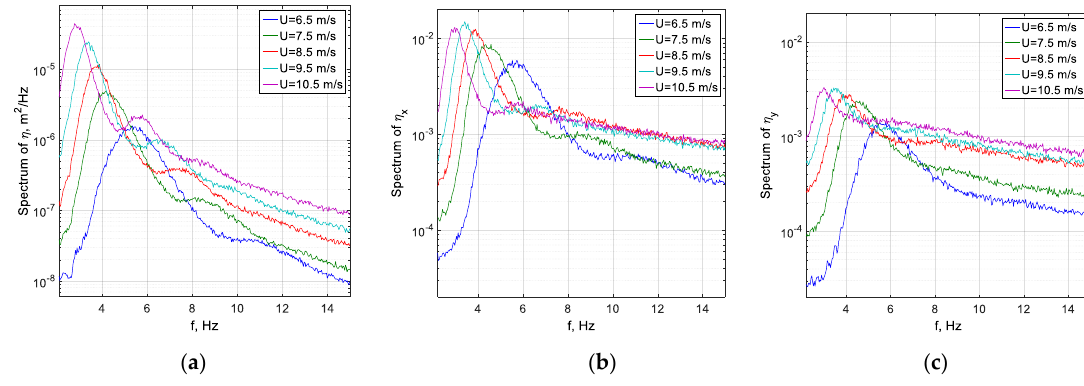
Figure 18. Power spectra at fetch x = 220 cm of ( a ) the surface elevation η ; ( b ) surface slope in the downwind direction, ∂ η/ ∂x; ( c ) surface slope in the crosswind direction, ∂ η/ ∂y.